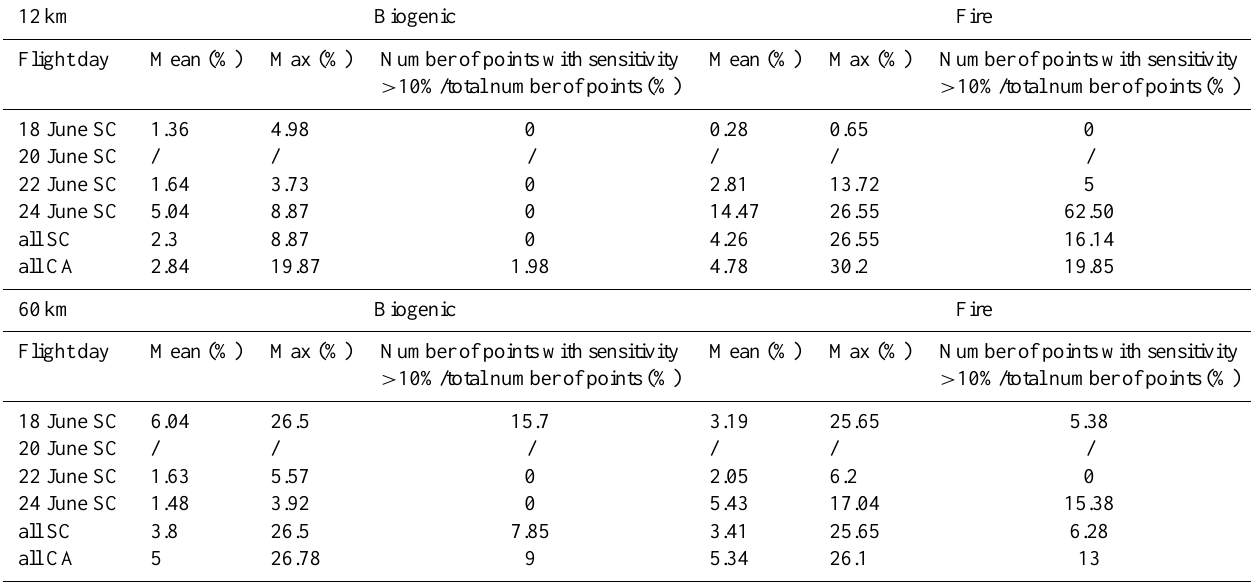
Table 2. Modeled O 3 sensitivity along flight paths below 1km from both resolution